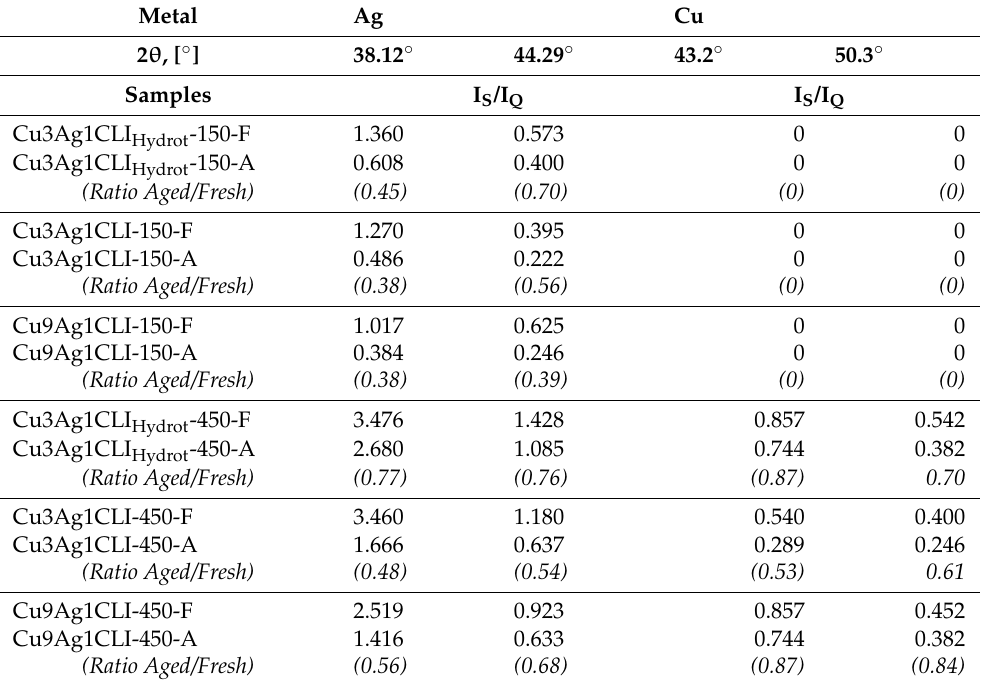
Table 1. Intensity ratio I S /I Q of the main diffraction peaks of Ag and Cu relatively to quartz peak at 2 θ = 26.25 ◦